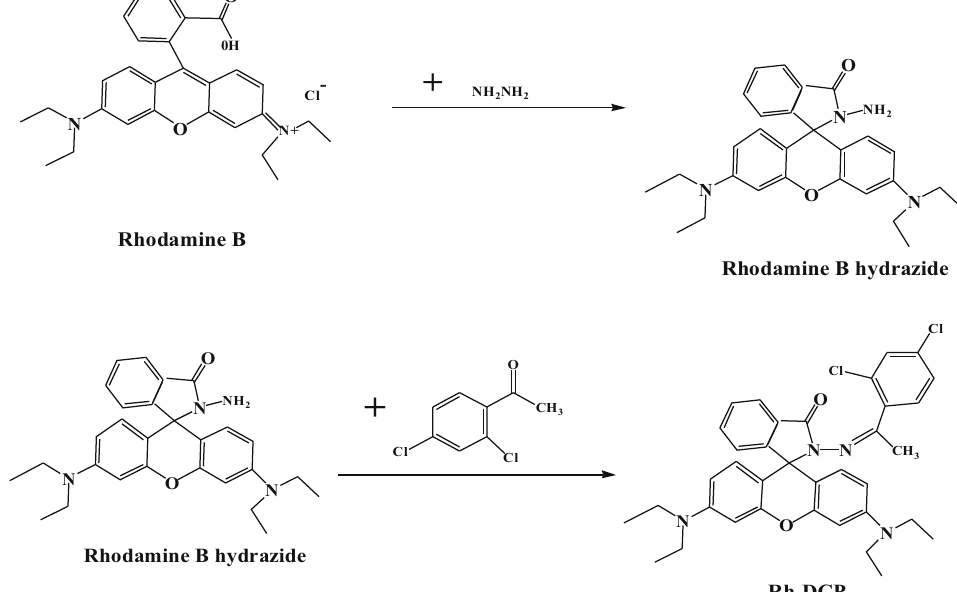
Figure 5: Synthesis of rhodamine B derivative Rh - DCP.